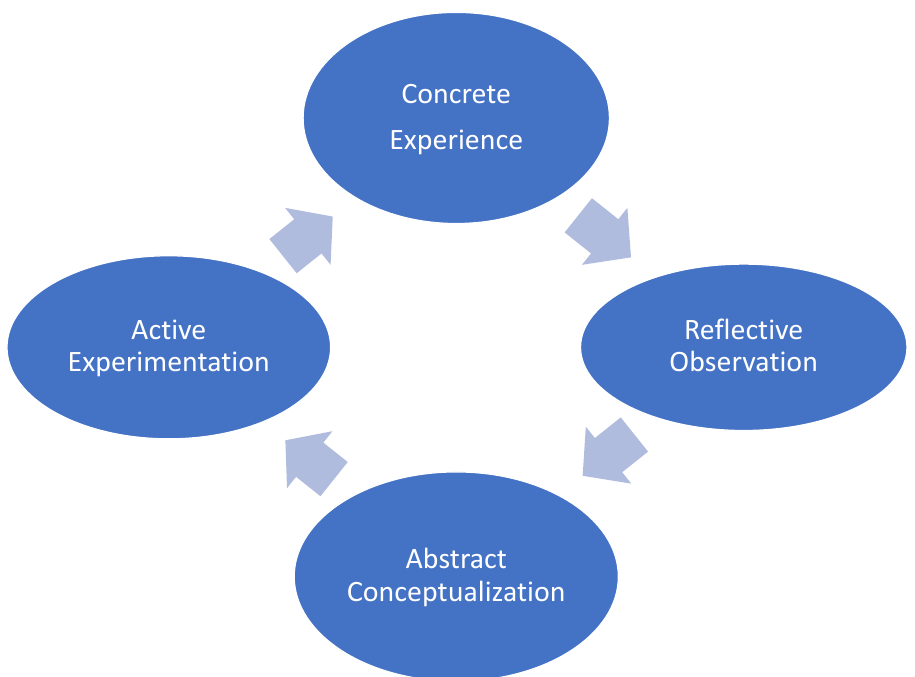
Figure 1. The framework of Kolb’s learning